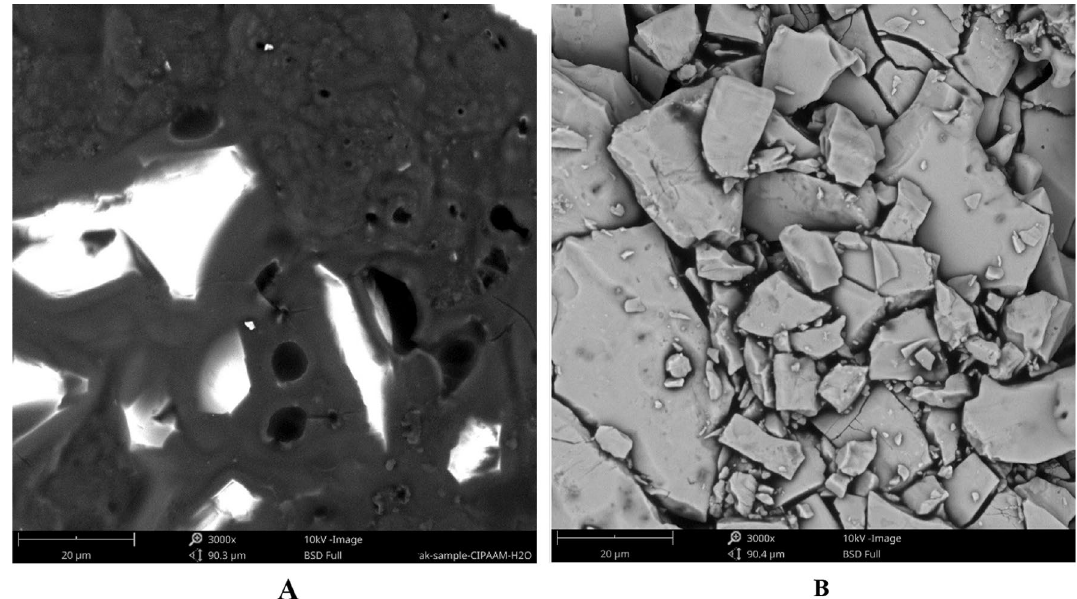
Figure 20. SEM image of cyclic polymers with magnification 3000. ( A ) cPNIPAAM produced in emulsion of SC-CO 2 in water; ( B ) cPNIPAAM produced by cyclization in homogeneous phase of SC-CO 2 and